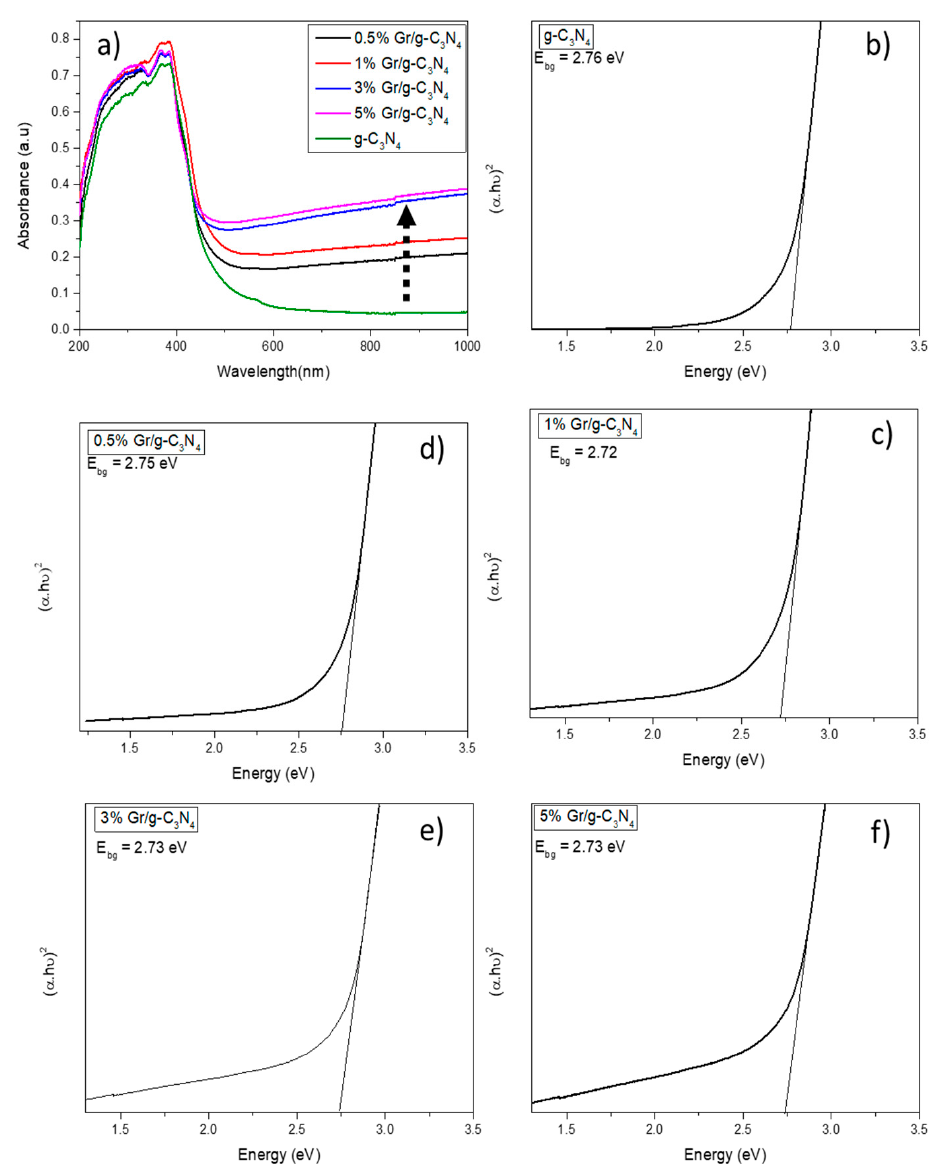
Figure 5. ( a ) UV diffuse reflectance spectra of the obtained samples; ( b – f ) the corresponding Tauc plot of the samples .